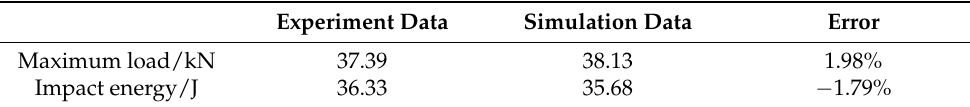
Table 4. Comparison of Charpy test and simulation results.